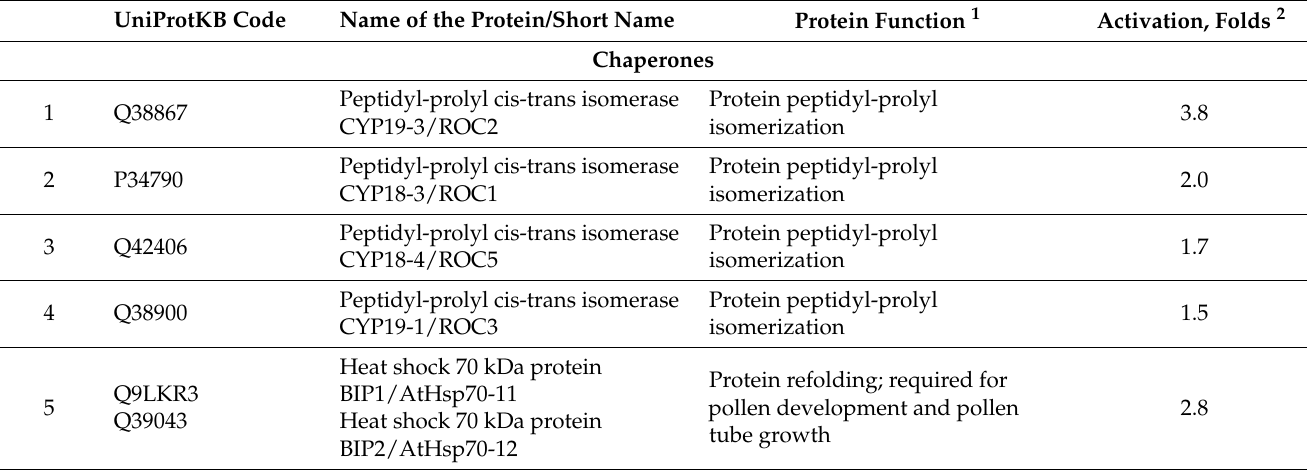
Table 1. Proteins upregulated in rolB -expressing Arabidopsis plants. UniProtKB